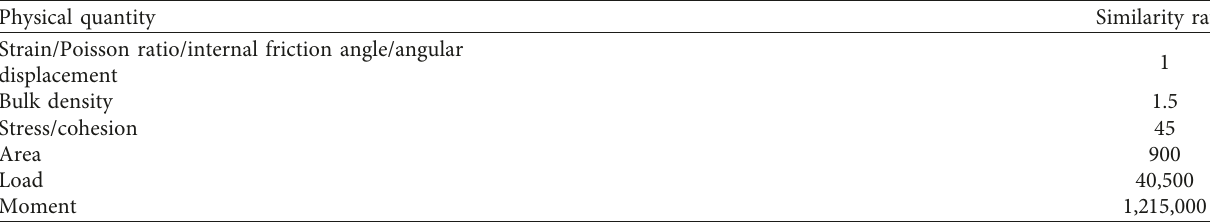
Table 3: Similarity ratio of other related physical